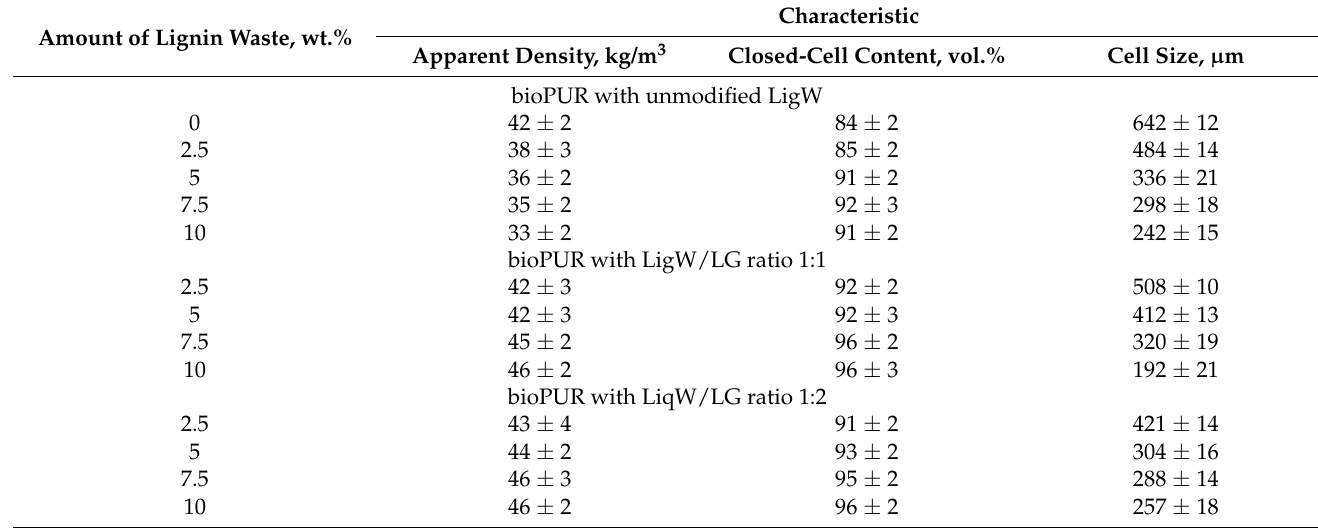
Table 4. Structural analysis results of bioPUR